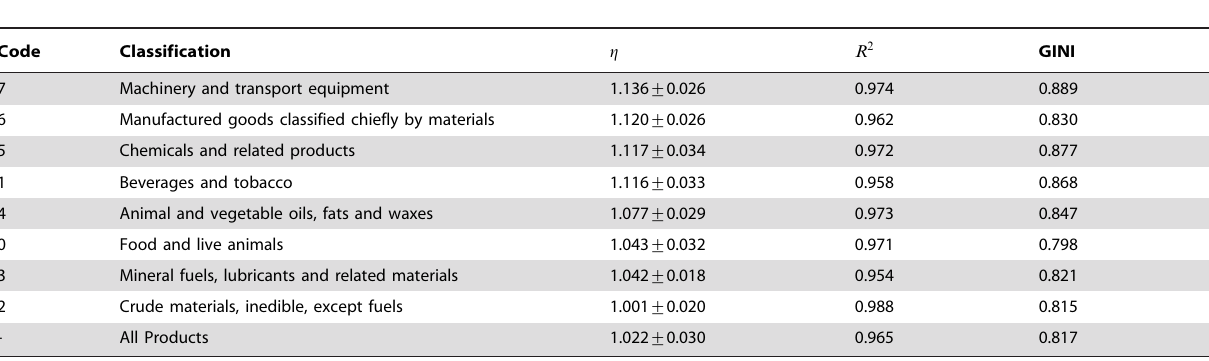
Table 1. Exponents of 1-digit SITC4 categories in UN data set.